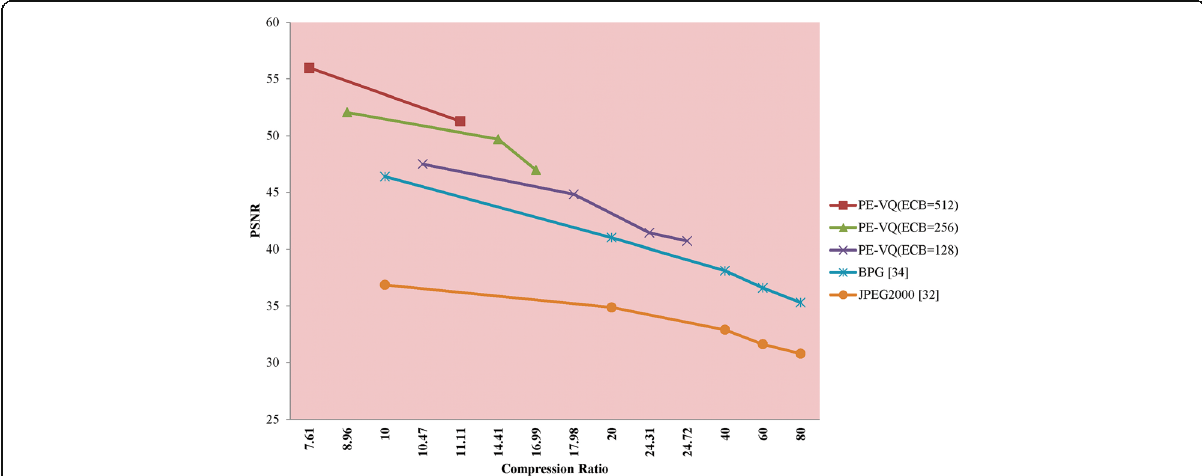
Fig. 18 Comparison of CR and PSNR values of PE-VQ method with existing methods using Lena image